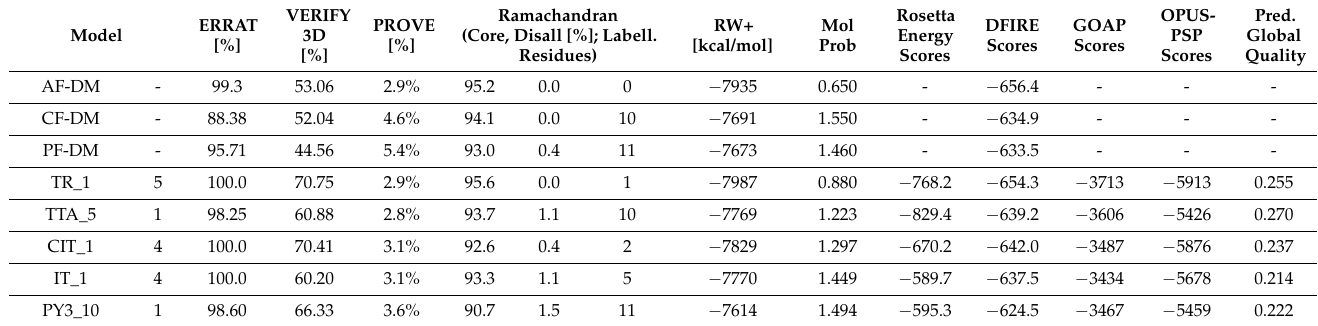
Table 1. Numerical estimates of 8 the best models, out of 15 considered, including values from SAVES,